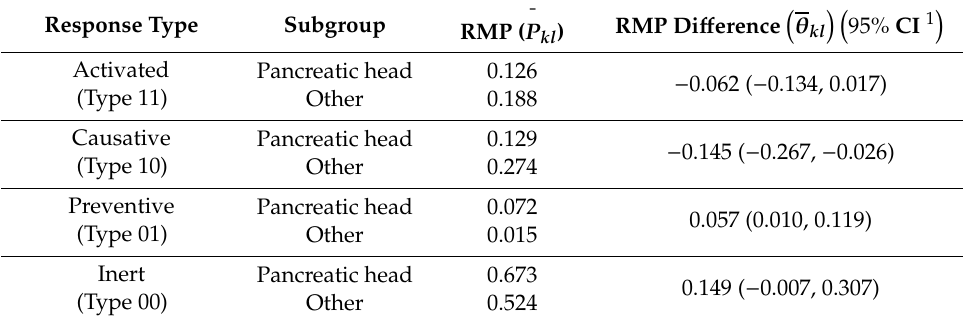
Table 2. Restricted mean probabilities (RMPs) of the four response types by subgroups of cancer site and the RMP differences between the two subgroups.